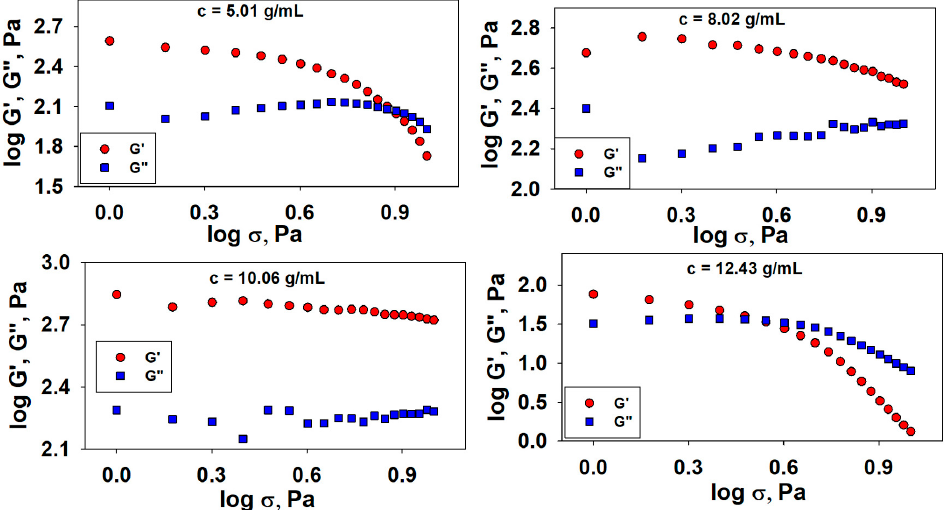
Figure 1. Log–log plots of storage (G ′ ) and loss moduli (G ″ ) versus shear stress ( σ ) for PSFEtP + so- lutions at different concentrations.